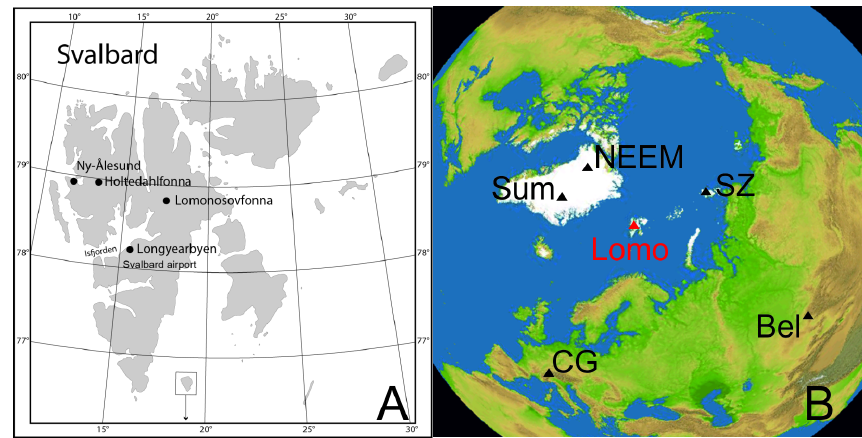
Figure 1. (a) Map of Svalbard with the locations of Lomonosovfonna and Holtedahlfonna. (b) Map with all ice-core locations discussed in the text: Lomo: Lomonosovfonna (red triangle); NEEM; Sum: Summit; SZ: Severnaya Zemlya; Bel: Belukha; and CG: Colle Gnifetti (black triangles). Satellite image in (b) PlanetObserver © , extracted from DVD-ROM “Der Große 3-D-Globus 4.0 Premium”, # 2008 United Soft Media Verlag GmbH,